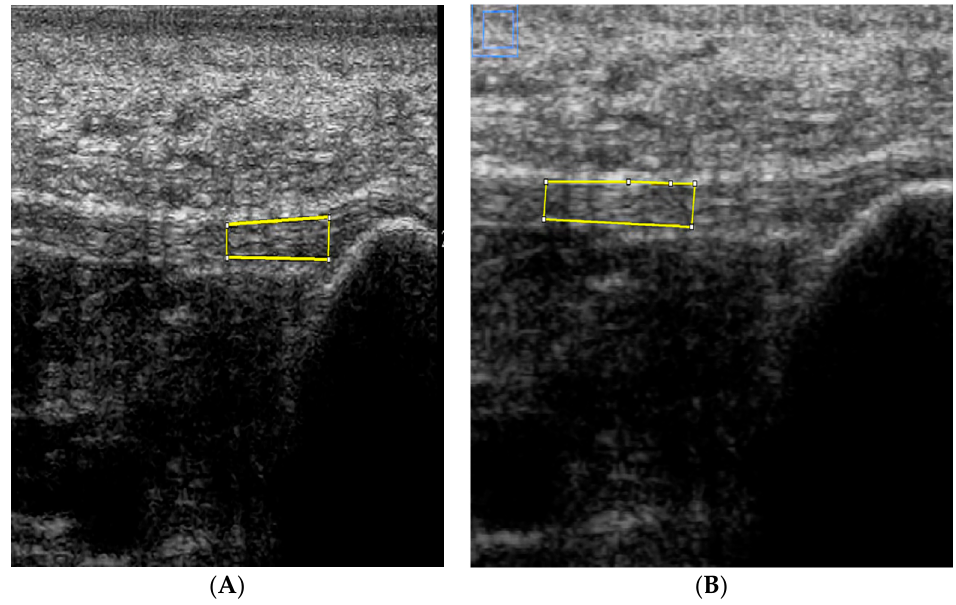
Figure 3. ( A ) Sonograph showing placement of regions of interest (ROI) at measurement stations along the length of the PF distally from insertion (0) to 1 cm distal; and ( B ) 1 to 2 cm distal from its insertion at the medial calcaneal tubercle with the yellow frame indicating the selected ROIs along the lengths of the PF.